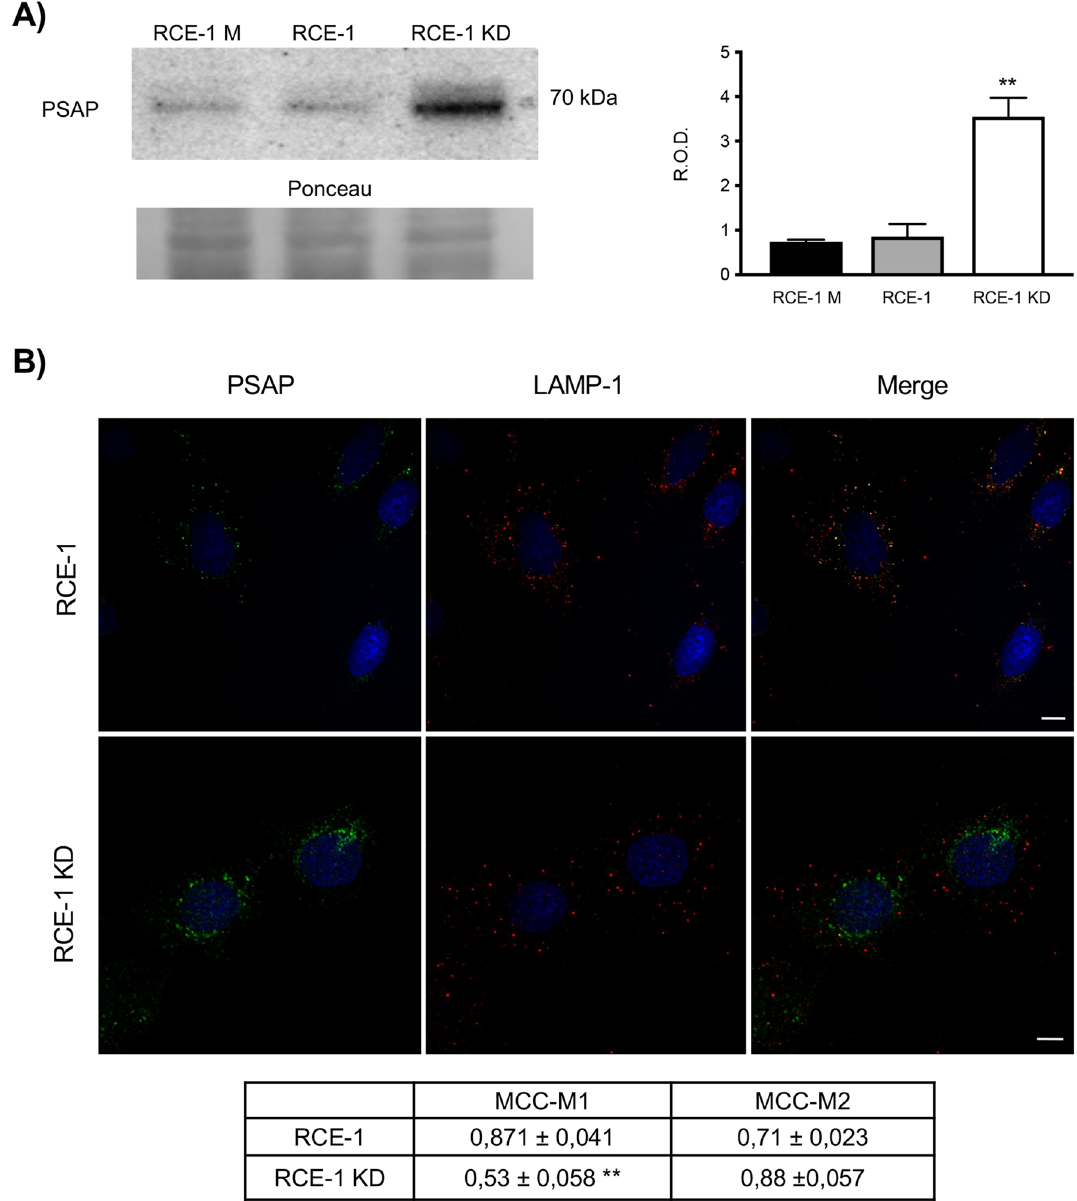
Figure 2. Effect of sortilin depletion on the expression and distribution of PSAP in RCE-1 cells. ( A ) Representative immunoblot of PSAP in RCE-1 M (mock-depleted), RCE-1 and RCE-1 KD cells and the corresponding quantification of bands. Bars represent the means of relative optical density (R.O.D.) ± SEM from three independent experiments. (**) significant difference from control and RCE-1 (p < 0.05). Ponceau S staining were used as loading control. The full-lenght immunoblot is presented in Supplementary Fig. 3. ( B ) Representative immunofluorescence staining of PSAP and LAMP-1 in RCE-1 and RCE-1 KD cells. Quantification of co-localization of PSAP and LAMP-1 (MCC-M1); LAMP-1 and PSAP (MCC-M2). Values are expressed as the means of Manders colocalization coefficients 1 and 2 (MCC-M1 and MCC-M2, respectively) ± SEM. (**) significant difference from RCE-1 (p < 0.05). Scale bars = 10